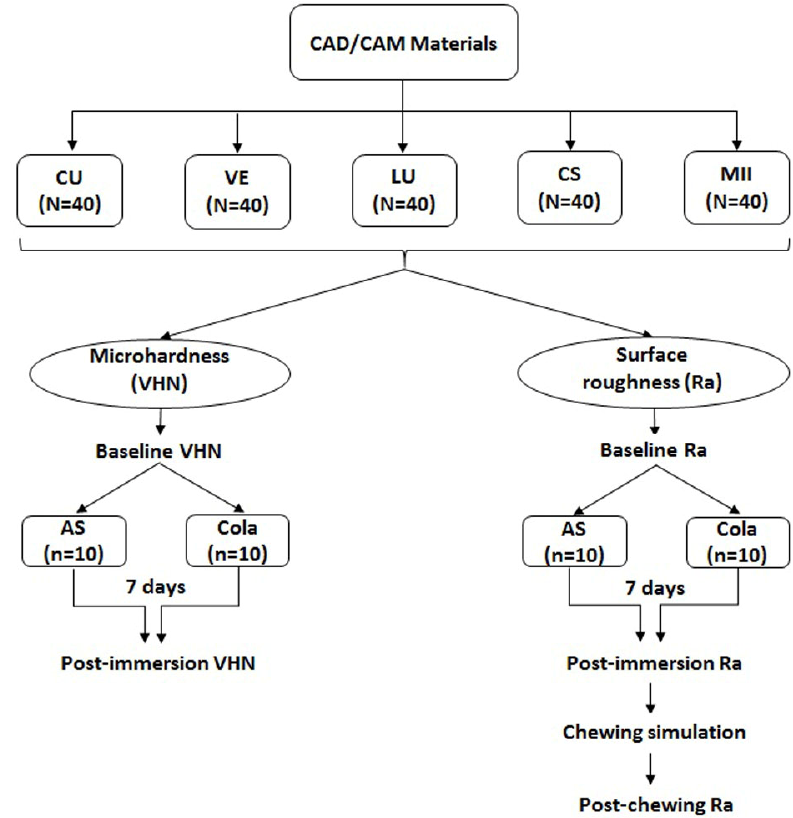
Figure 1. Specimen distribution and test set-up.